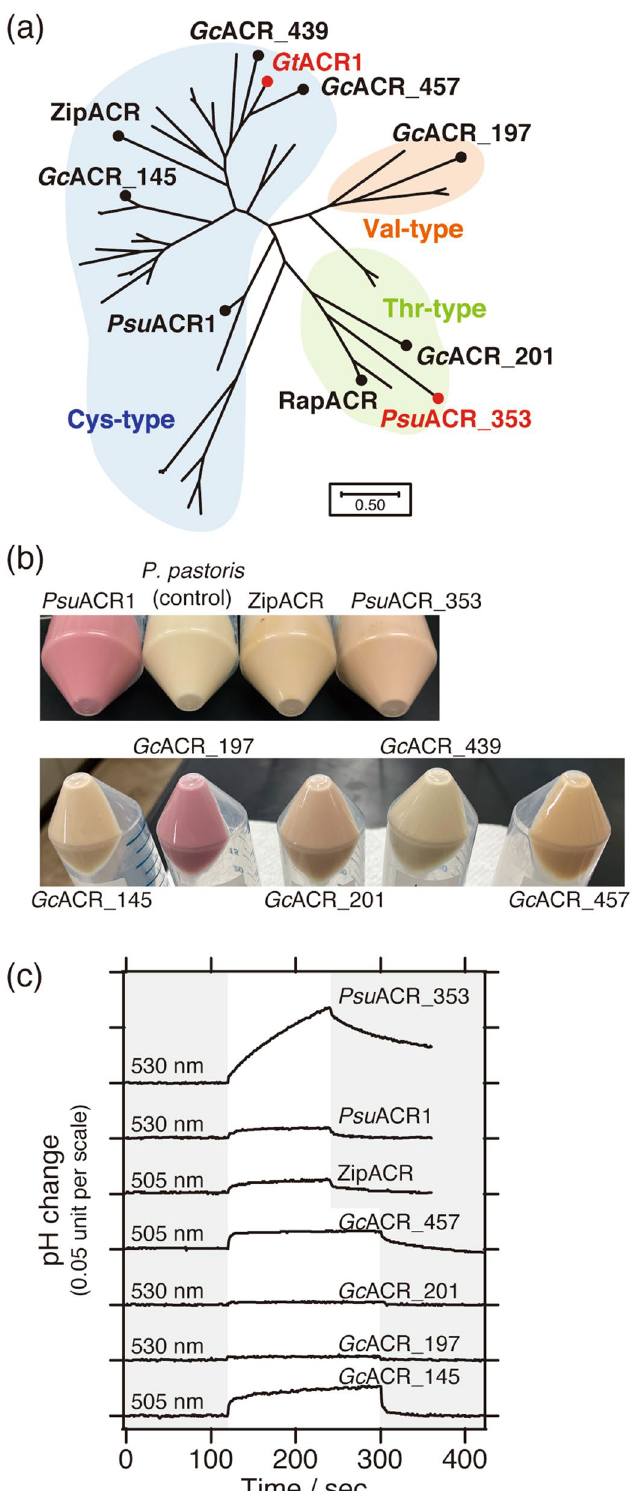
Figure 3. ACRs tested using the pH electrode method. ( a ) Phylogenetic relationship of 45 ACRs analyzed by MEGA 7 software. According to amino acids conserved at position 102 in Gt ACR1, ACRs are classified into three types, Cys-type (blue), Thr-type (green) and Val-type (orange). ( b ) Pictures of pigmented yeast cells due to the functional expression of each ACR in the presence of all- trans -retinal. The negative control was yeast cells without integration of any ACR gene. ( c ) Comparisons of Cl − transport activities of ACRs. LED lights were illuminated for 2 or 3 min as shown on a white